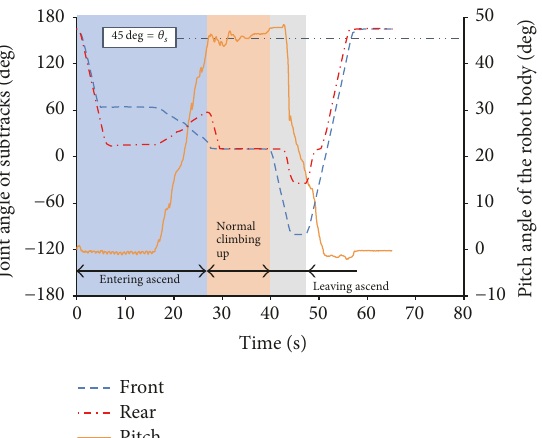
Figure 26: Data profile for 𝜃 𝑓 , 𝜃 𝑟 , 𝜃 𝑝 ( 𝜃 𝑠 = 45 ∘ , 𝑝 = 200 mm, ascend).